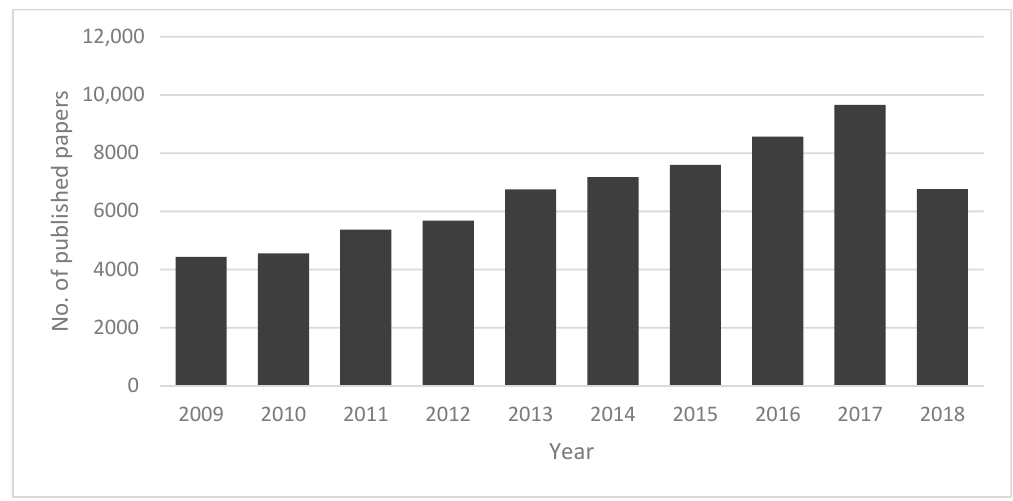
Figure 2. Number of published scientific papers worldwide per year (from 2009 to 2018) on the applications of ionic liquids in sample preparation techniques (based on Scopus and ScienceDirect).